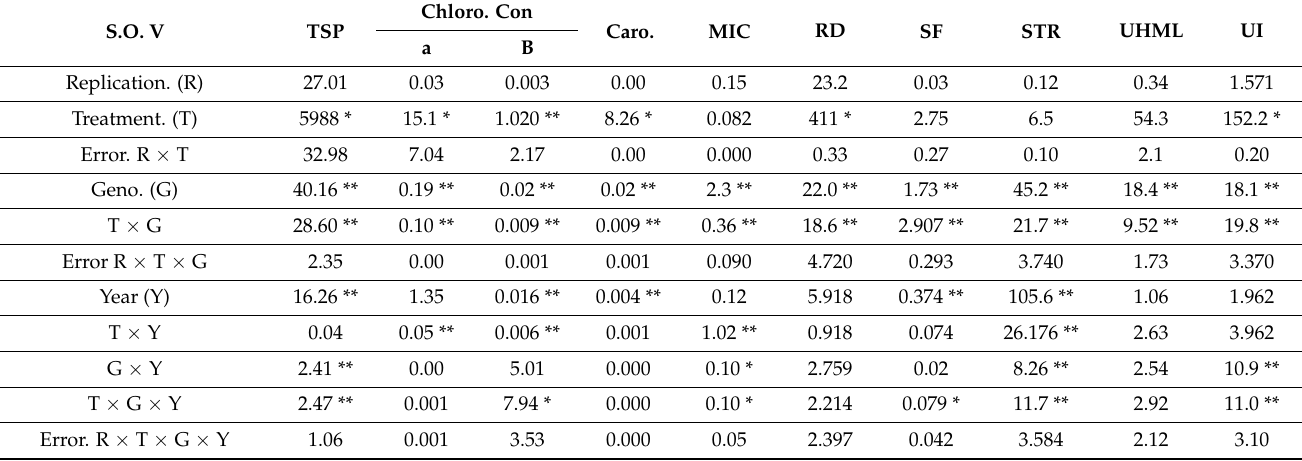
Table 3. Mean squares value from ANOVA of Heat × Year × Genotypes